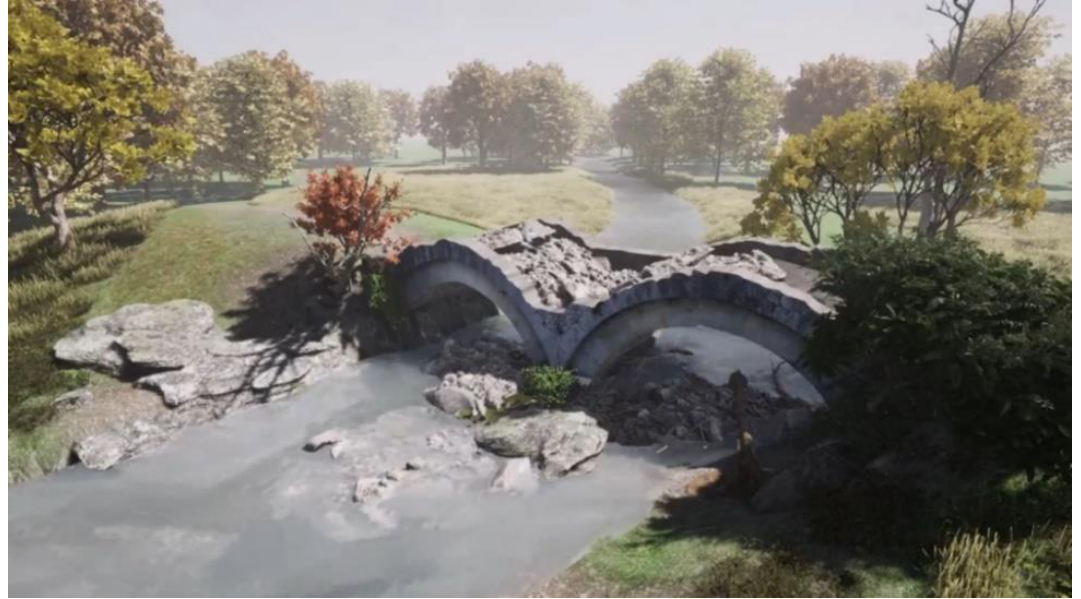
Figure 11. Virtual reconstruction of the bridge in the collapse phase (Reconstruction by A. Cordisco).